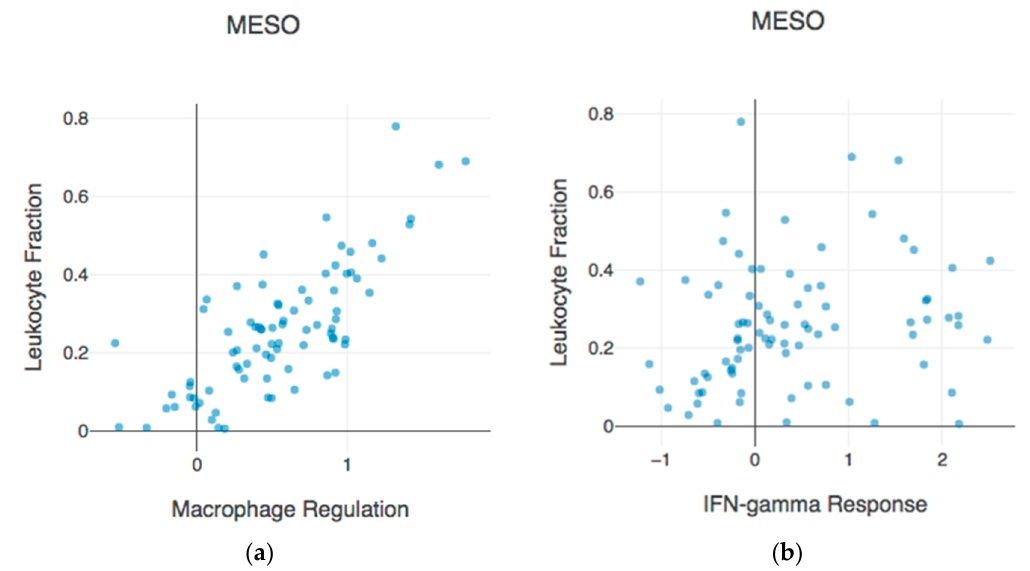
Figure 1. Mesothelioma leukocyte fraction is highly correlated with the signature “Macrophage regulation” ( a ) compared with the correlation with IFN-gamma response ( b ). These graphics were obtained using the interactive web-based platform https://www.cri-iatlas.org/ [23].